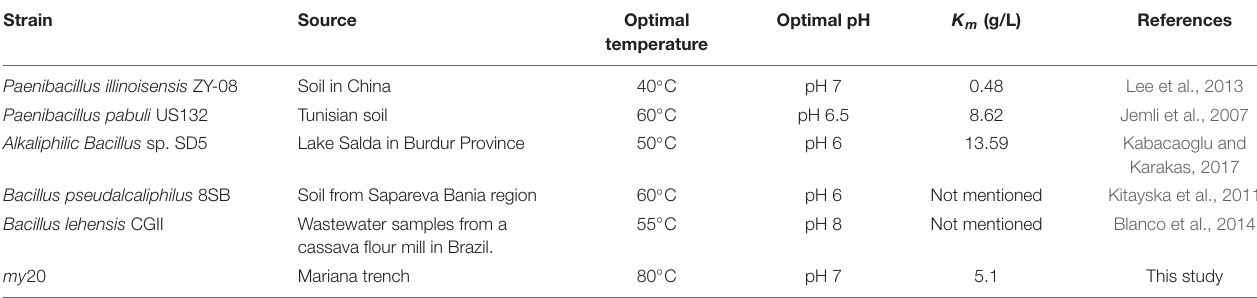
TABLE 3 | Properties of CGTase from different strains.